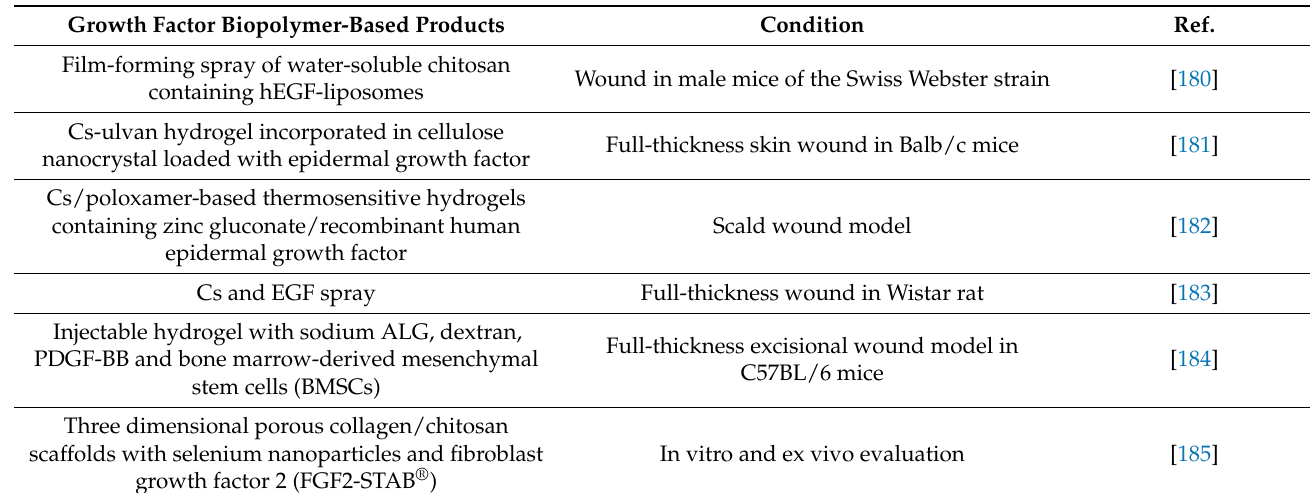
Table 4. Growth factor biopolymer-based